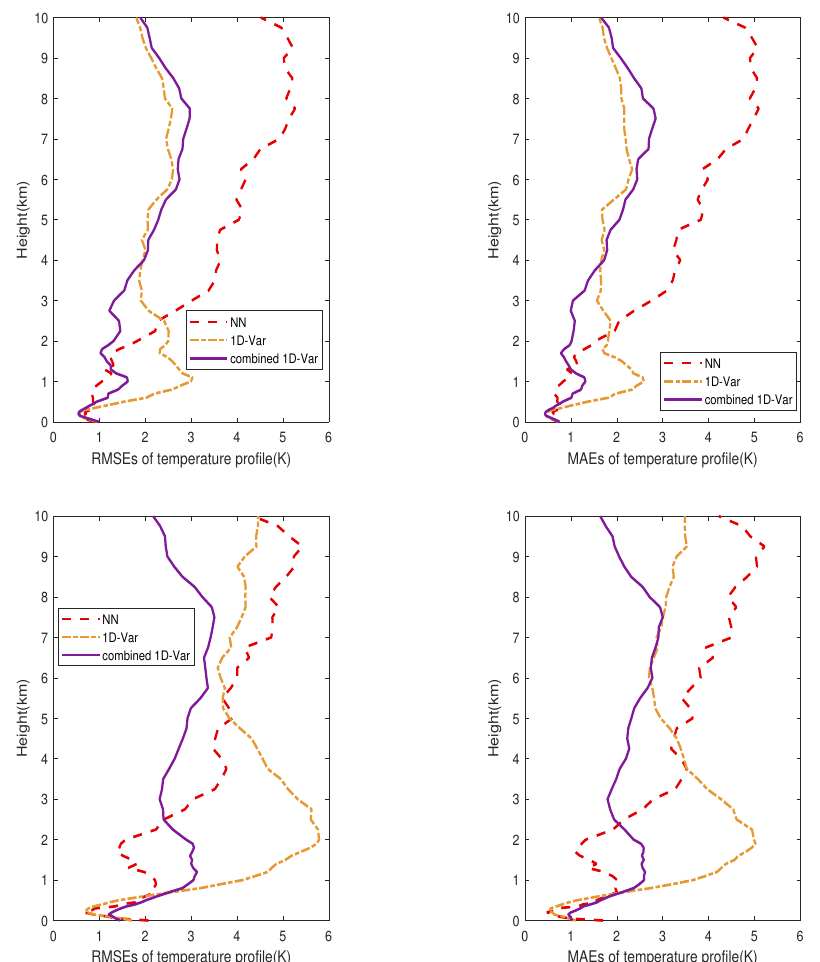
Figure 5. The RMSEs ( left ) and MAEs ( right ) profiles for temperature via the NN (red dashed), 1D-Var (yellow dashed), and combined 1D-Var (purple solid) methods for daytime cases ( top row ) and night cases ( bottom row